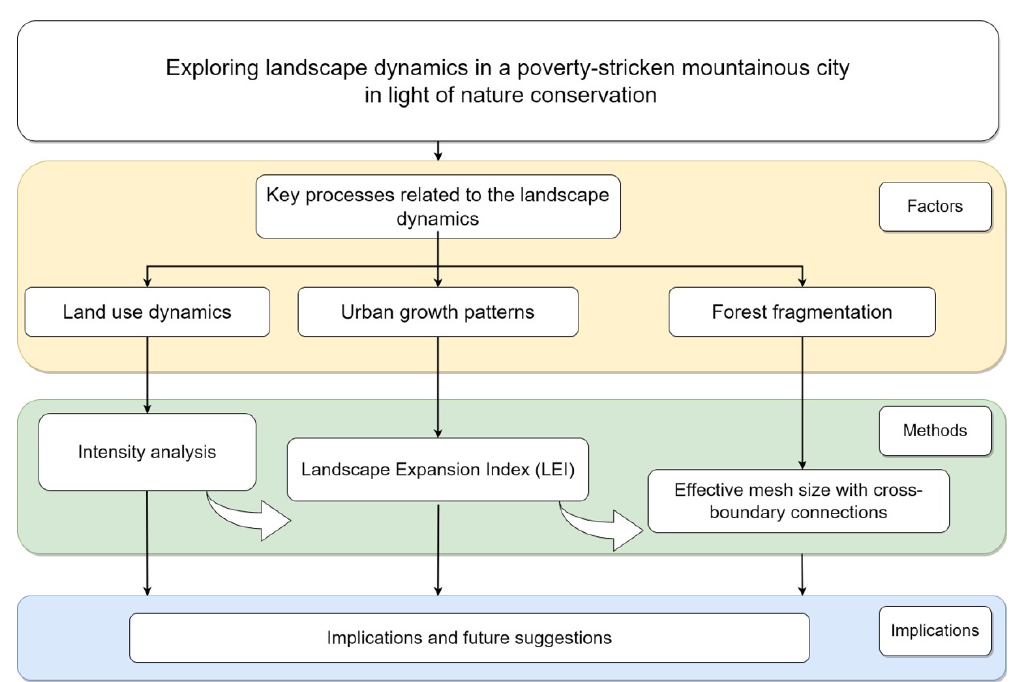
Figure 2. Analytic framework of this study.